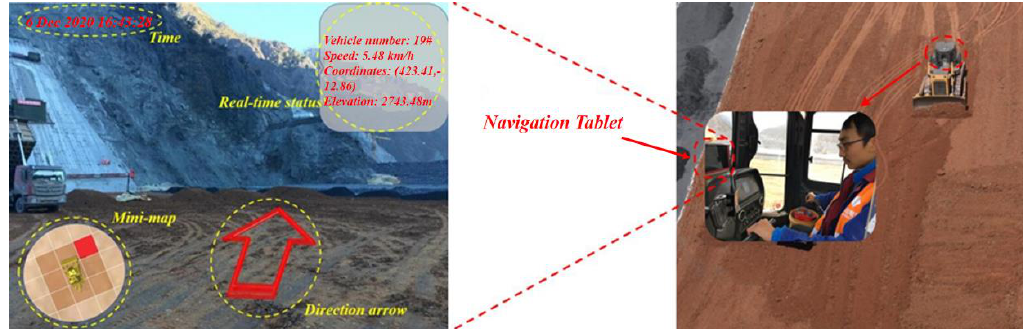
Figure 12. Real-time path optimisation based on feedback control.